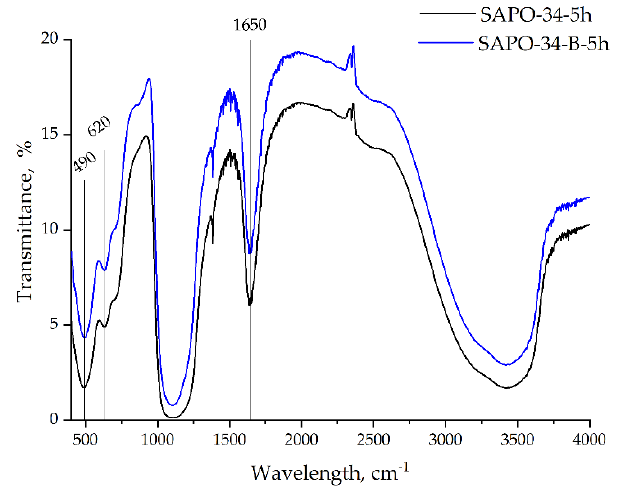
Figure 3. FT − IR spectra of SAPO-34 samples synthesized from AIP (SAPO-34 − 5h) and boehmite (SAPO-34 − B − 5h).